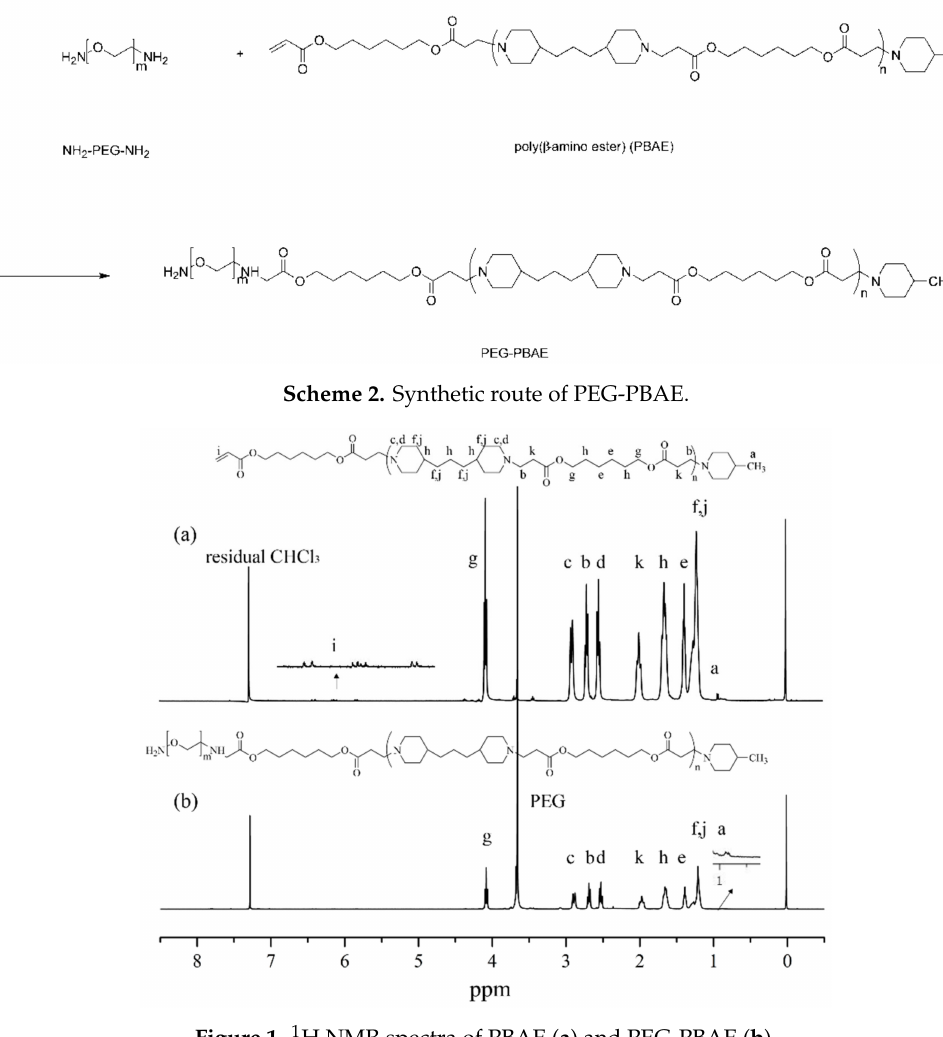
Figure 1. 1 H NMR spectra of PBAE ( a ) and PEG-PBAE ( b